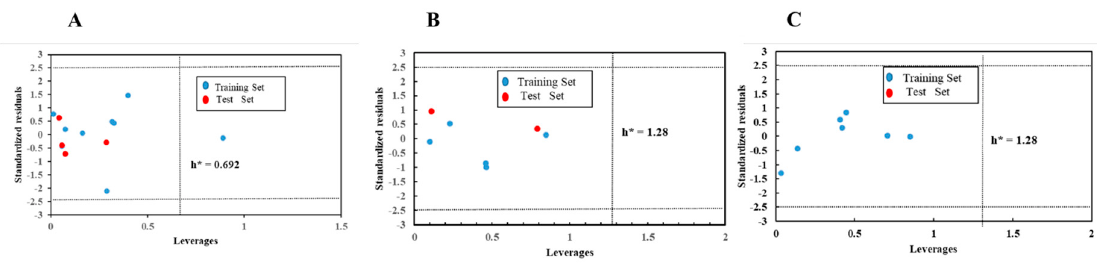
Figure 6. Williams plot for verifying the applicability domain of the model. ( A ): LD 50 ; ( B ): IC 50 ; ( C ): Nrf2.